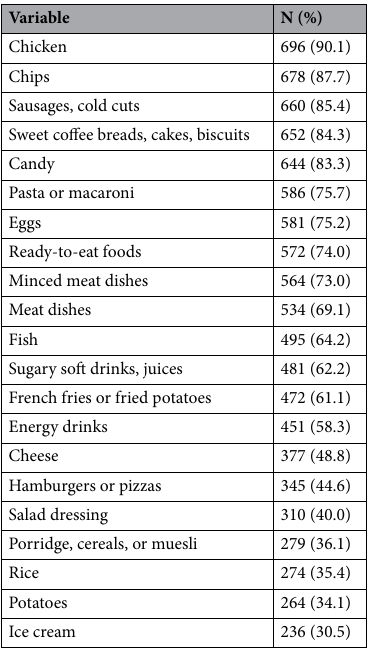
sausages/cold cuts (85.4%), and finally sweet coffee breads, cakes, and biscuits (84.3%). The least popular food types among respondents were ice cream (30.5%), potatoes (34.1%), and rice (35.4%). Data grouping. PCA was conducted to identify wider categories of related food types, as well as to optimize further analyses. The PCA analysis proposed the extraction of four factors. The loading of each item was higher than 0.30. Sums of squared loadings were 6.71, 2.28, 1.25, and 1.18, respectively. The four factors accounted for 54.41% of the variance (Factor 1: 31.97%, Factor 2: 10.87%, Factor 3: 5.95%, and Factor 4: 5.62%). The first factor grouped eight types of food that corresponded to salad, carbohydrate-rich, and fast foods. This factor included food types such as porridge, salad dressing, rice, cheese, eggs, hamburgers/pizzas, potatoes, and pasta or macaroni. The second factor grouped eight items and was related to meat and fish-based food (sausages/ cold cuts, ready-to-eat foods, chips, chicken, minced meat dishes, fish, French fries/fried potatoes, and meat dishes). The third factor included sweet types of food and re-categorized three items (ice cream, candy, and the analysis, as it loaded similarly on three factors (specifically Factors 1, 3, and 4).